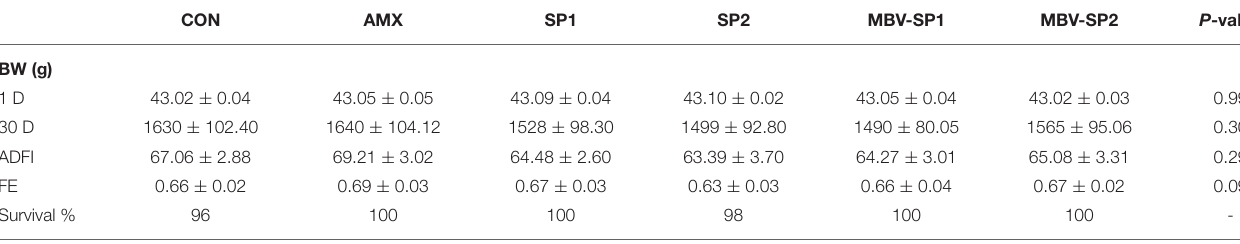
TABLE 2 | Dietary effects of feeding AMX, SP1, SP2, MBV-SP1, and MBV-SP2 on growth performance of